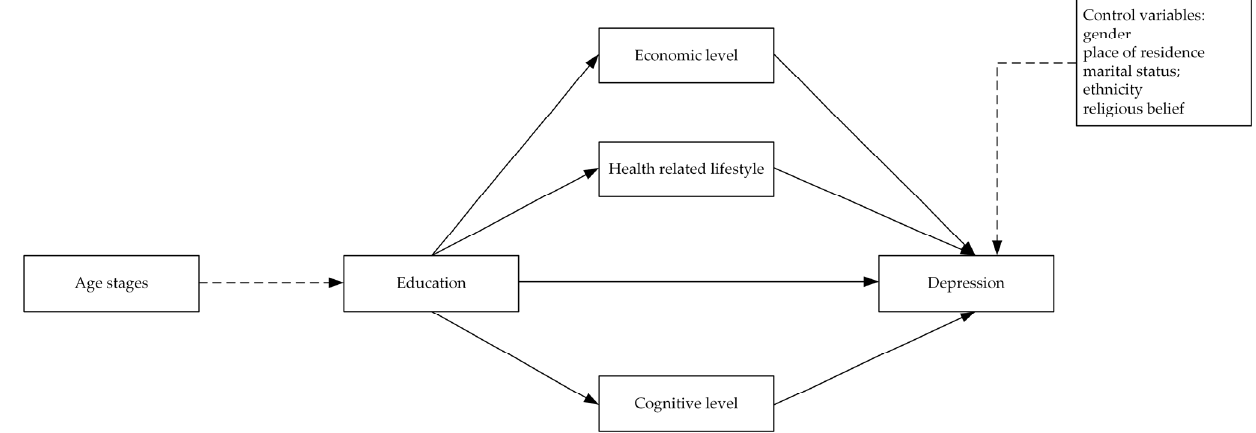
Figure 2. A theoretical framework for the impact of education on depression.